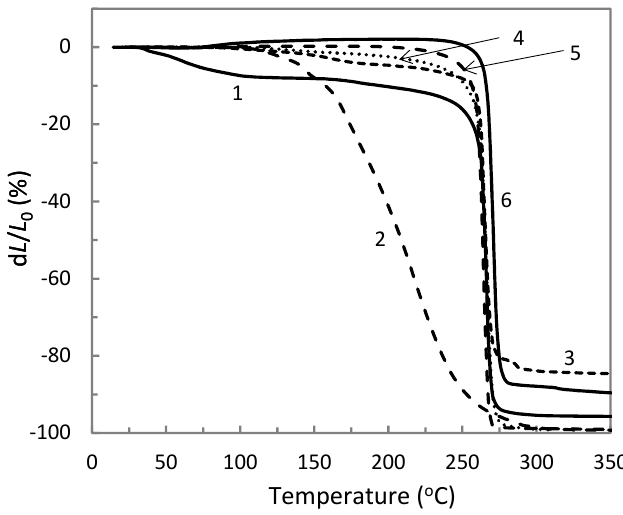
Figure 5. Thermomechanical curves of neat ETFE (1), AP synthesized at 270 °C (2), ETFE/AP com- posites with the compositions 30/70 (3), 50/50 (4), 70/30 (5), and ETFE/TiO 2 with the composition 65/35 (6) (wt %). In the case of the composites AP was also synthesized at 270 °C.